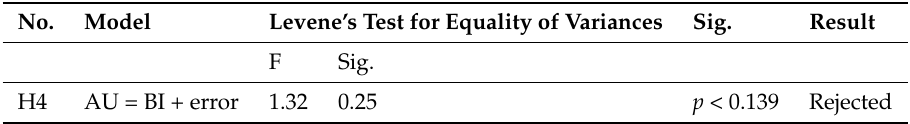
Table A9. Result of Hypothesis 4 (Independent Sample T -test).